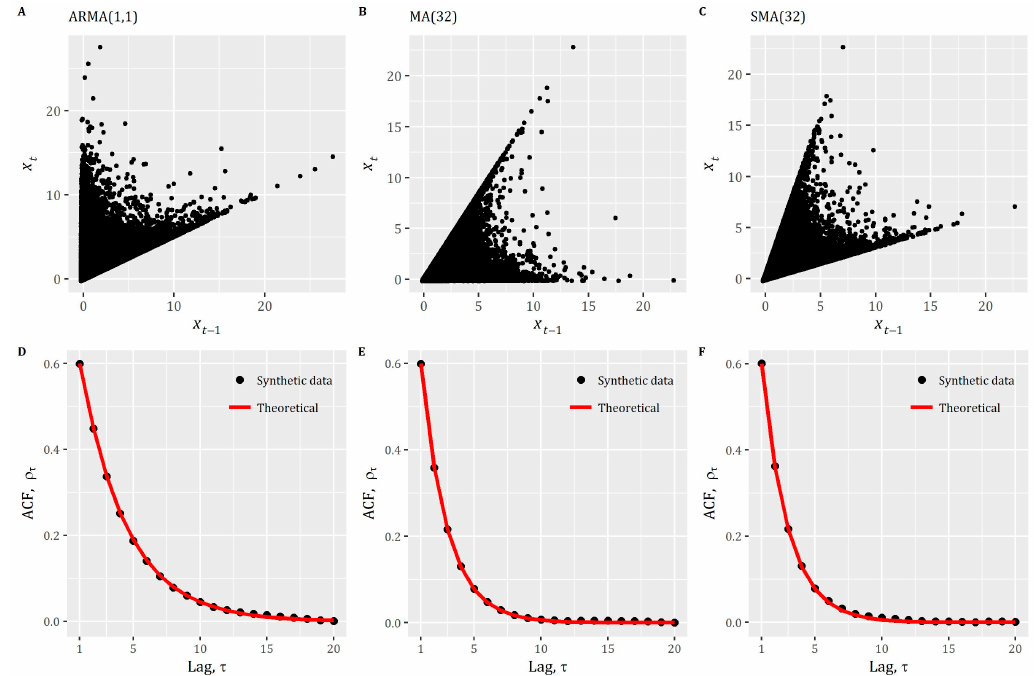
Figure 6. Scatter plots depicting the simulated lag-1 dependence pattern among consecutive